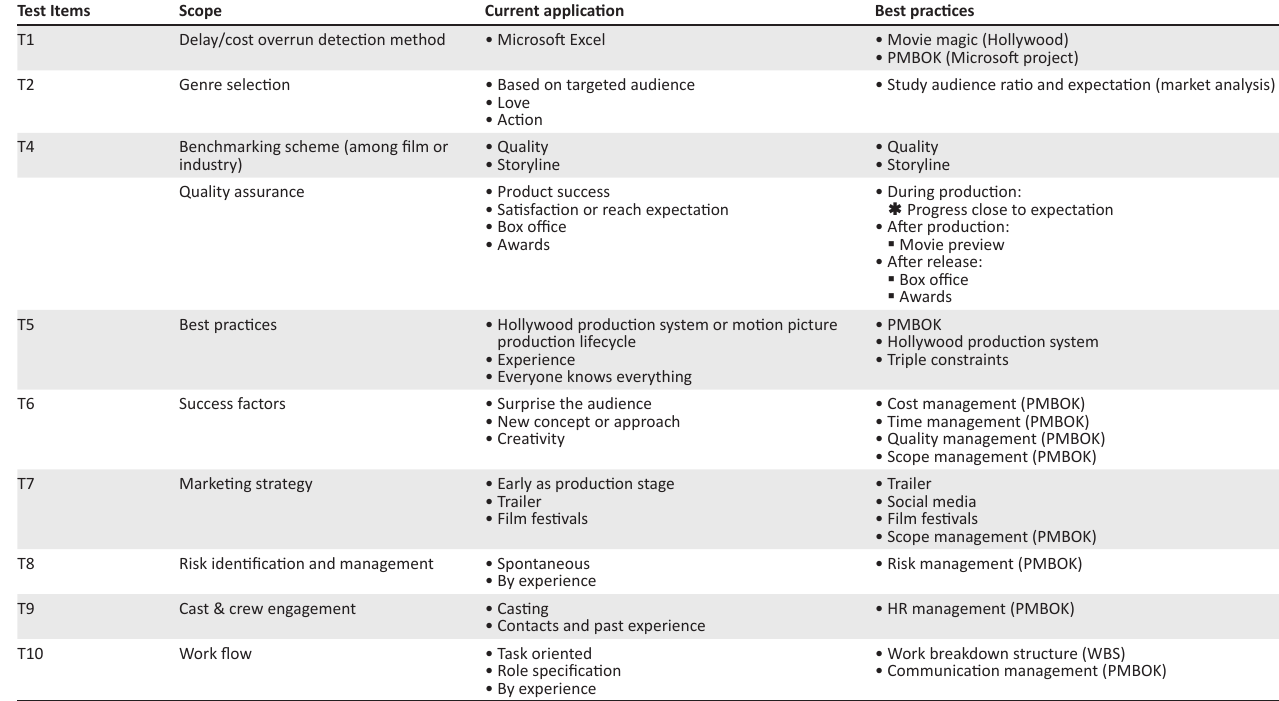
TABLE 6: Content analysis on interview survey. Test Items